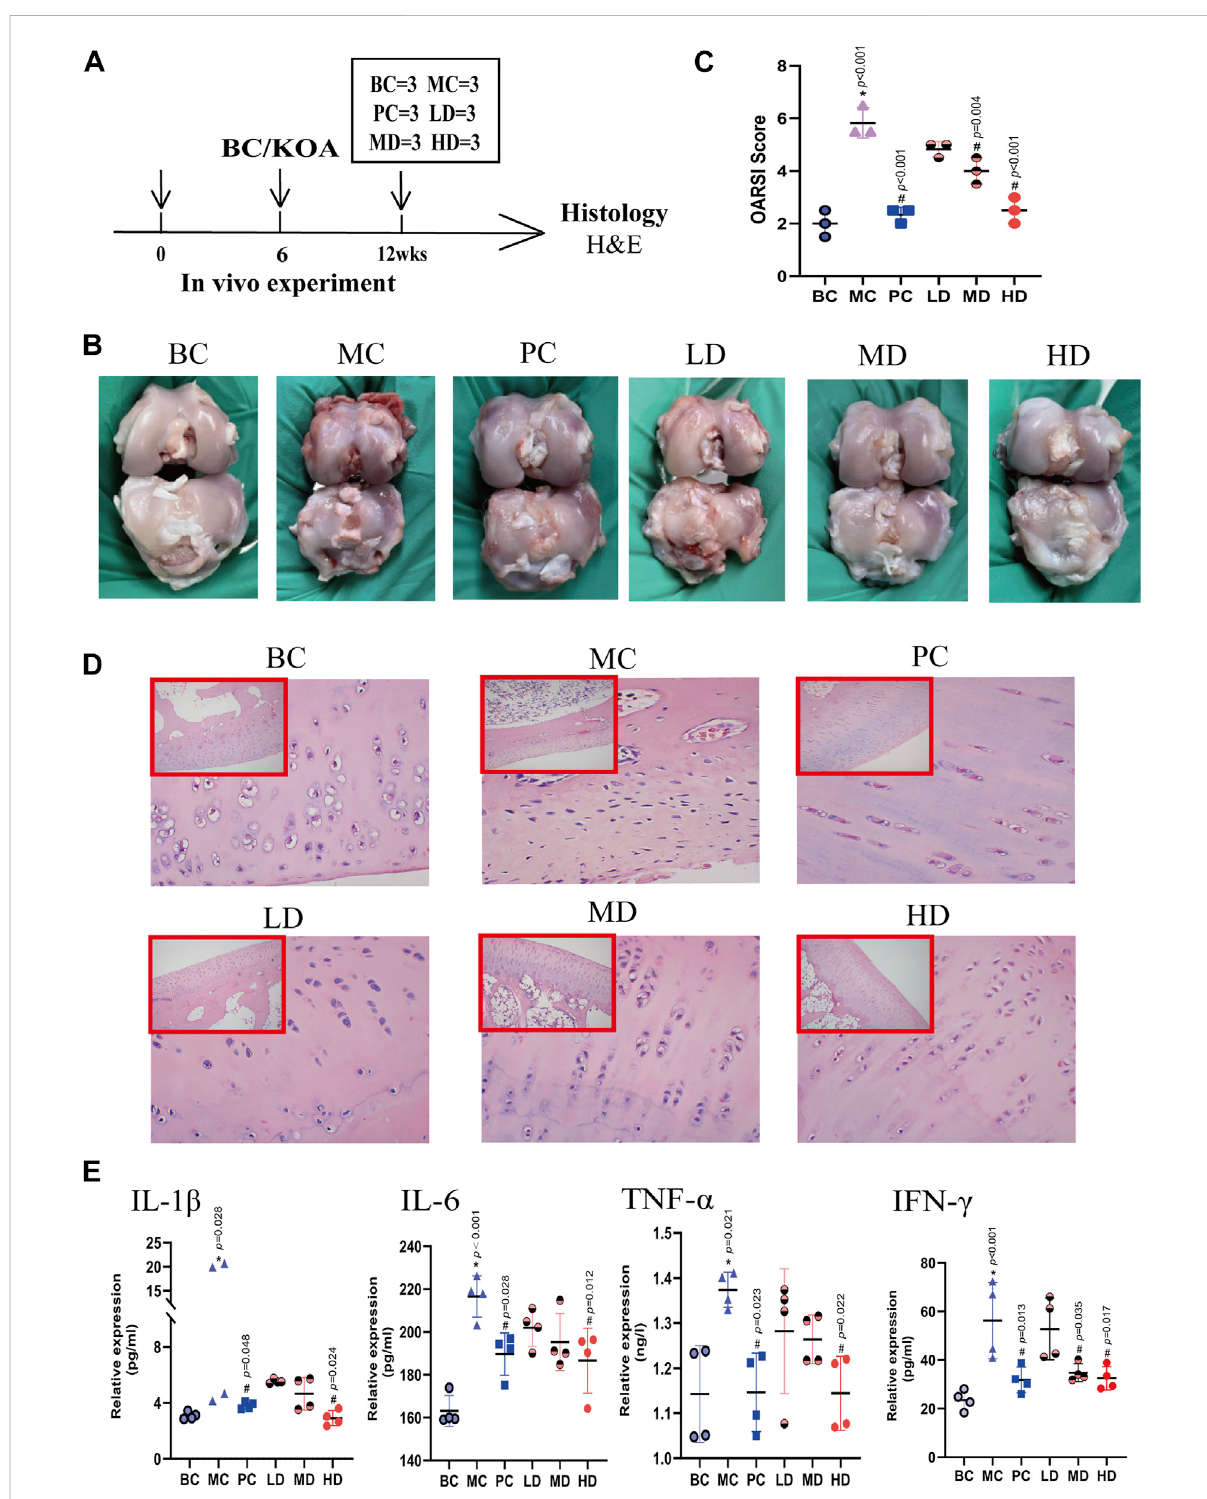
FIGURE 4 Effect of ZFTG on KOA rabbit. (A) Experimental design. The rabbits were killed for H&E analysis at 12 weeks ( n = 3/group). (B) Anatomical appearance of rabbit knee joint. (D) Representative images and (C) histomorphometric analyses of H&E-stained sections for OARSI score. The images are magni fi ed 100× (inside the red rectangular frame) and 400×. (E) IL-1 β , IL-6, TNF- α , and IFN- γ levels were measured by the ELISA kit according to the manufacturer ’ s instructions. One-way analysis of variance was used for comparing the OARSI scores. The data are presented as mean ± SD. * p < 0.05, vs. BC group; # p < 0.05, vs. MC group. Speci fi c p -values for each pair of comparisons are